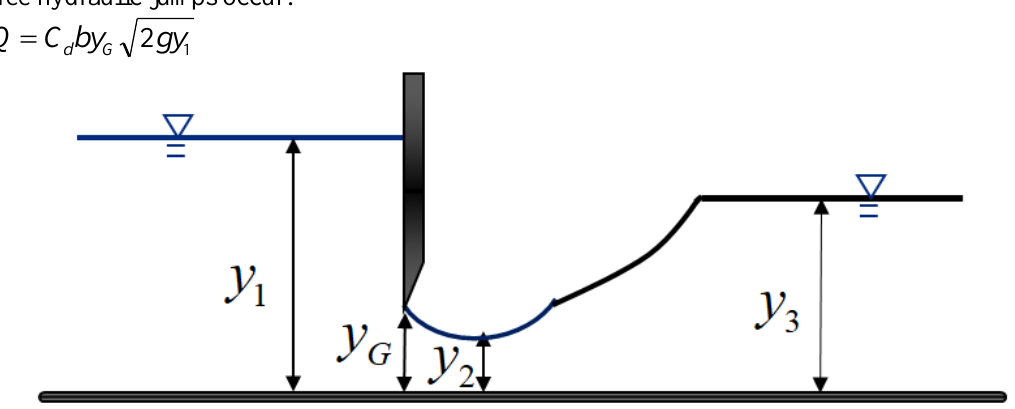
Figure 1. Free hydraulic jump in a slide gate